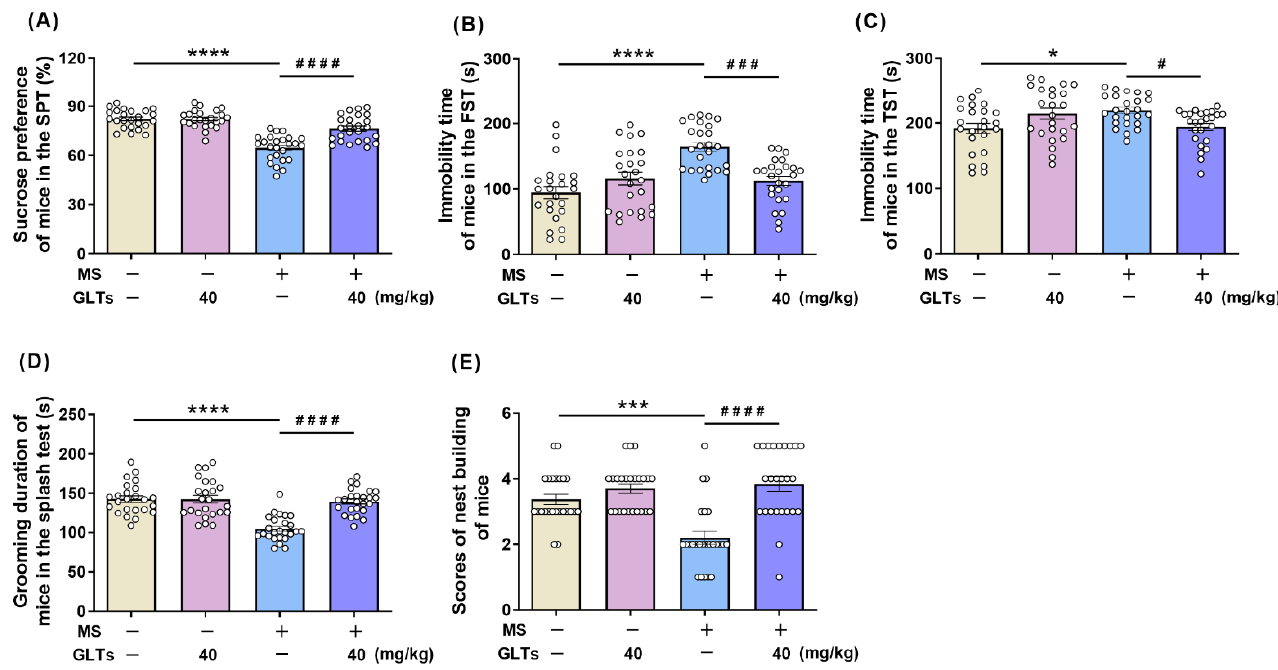
Figure 2. The reduced susceptibility to depression-like behaviors in MS mice by preemptive GLTs treatment. ( A ) Sucrose preference of mice in the SPT. ( B ) Immobility time of mice in the FST. ( C ) Immobility time of mice in the TST. ( D ) Grooming duration of mice in the splash test. ( E ) Nest-building scores of mice in the nest-building test. Data are expressed as mean ± SEM. Control + vehicle group, n = 24 (male: n = 11; female: n = 13); Control + GLTs (40 mg/kg) group, n = 24 (male: n = 11; female: n = 13); MS + vehicle group, n = 25 (male: n = 12; female: n = 13); MS + GLTs (40 mg/kg) group, n = 25 (male: n = 12; female: n = 13). * p < 0.05, *** p < 0.001, **** p < 0.0001, as compared with Control + vehicle group; # p < 0.05, ### p < 0.001, #### p < 0.0001, as compared with MS + vehicle group.